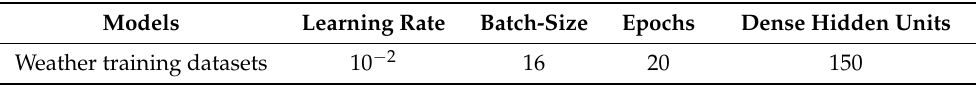
Table 2. Hyper-parameters configuration for weather datasets.